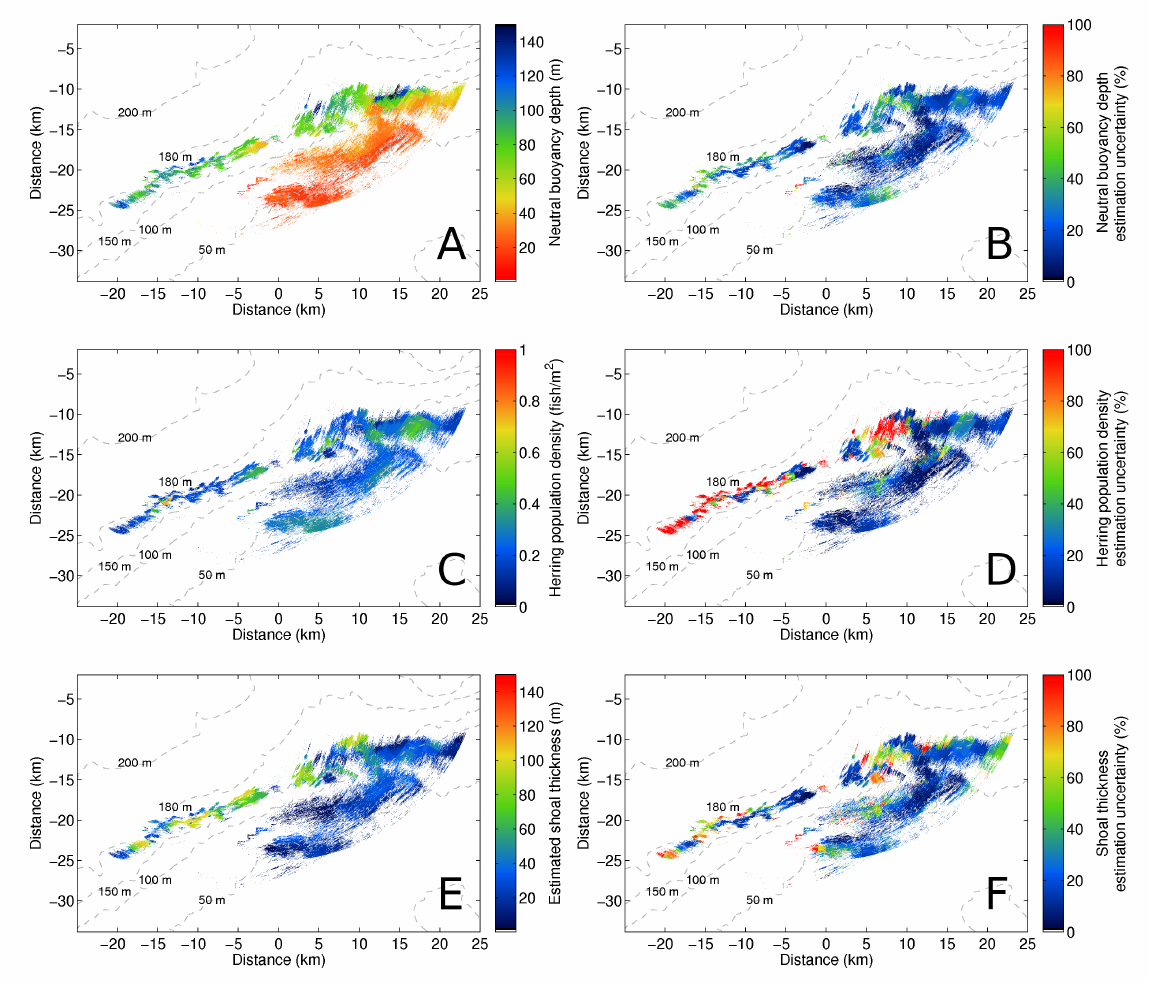
Figure A2. ( A ) the horizontal distribution of neutral buoyancy depth; ( B ) estimation uncertainty for neutral buoyancy depth in percentage; ( C ) the horizontal distribution of herring population density; ( D ) estimation uncertainty for herring population density in percentage; ( E ) the horizontal distribution of root-mean-square √ (RMS) shoal thickness H RMS = 2 H / 12, where H = | max z − min z | , and z is the herring occupancy depth; ( F ) estimation uncertainty for RMS shoal thickness in